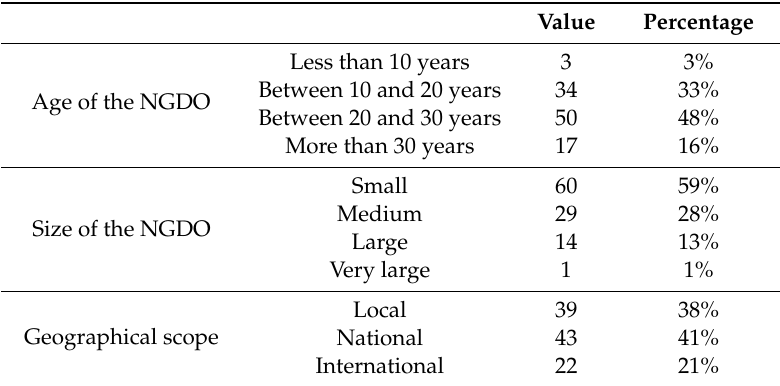
Table 2. Descriptive analysis of the NGDO sample.